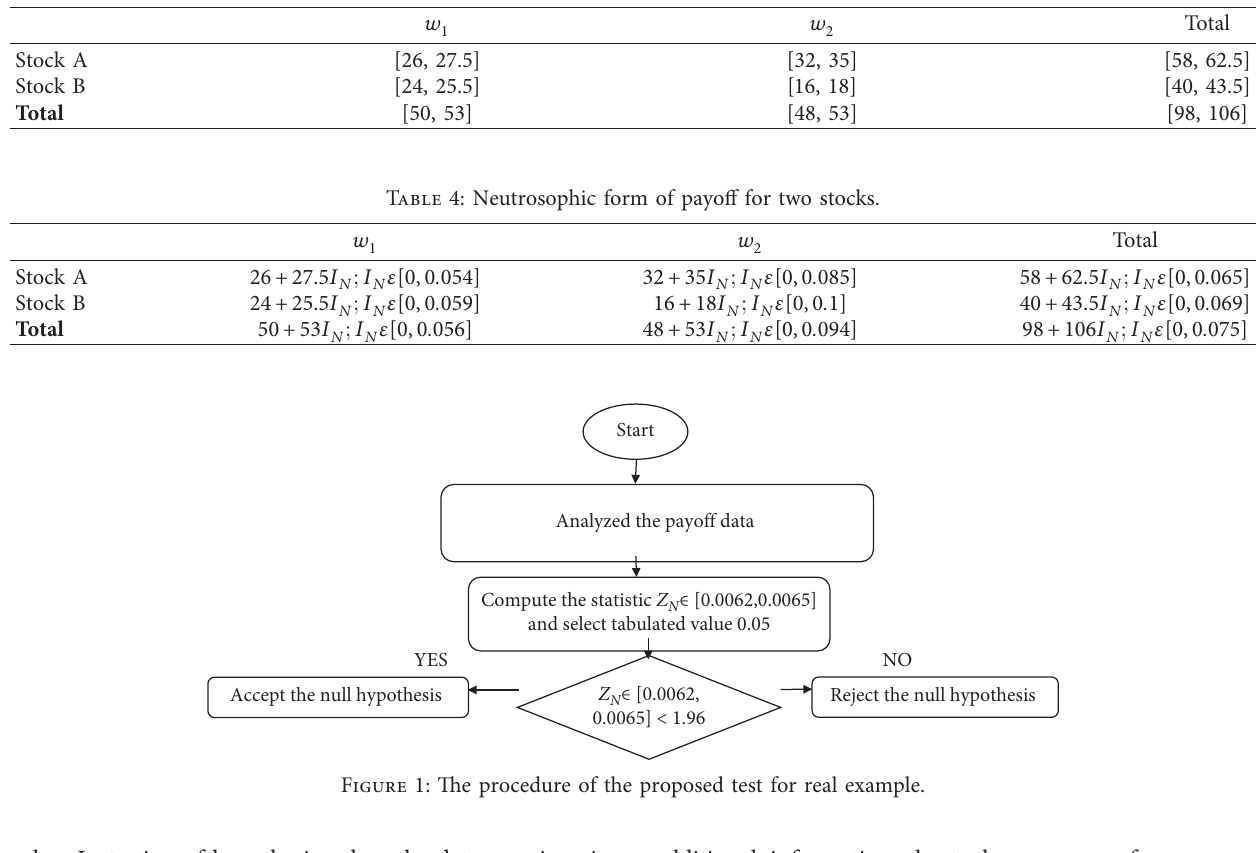
Table 3: Payoff for two stocks.